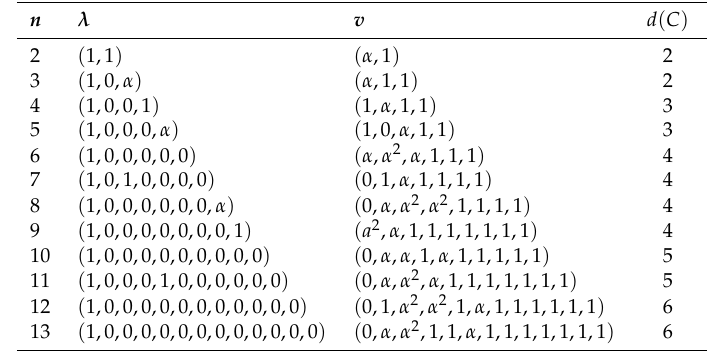
Table 1. Half-rate vector-circulant based additive codes of length n over F 4 = { 0,1, α , α 2 = 1 + α } generated by cir λ ( v ) .